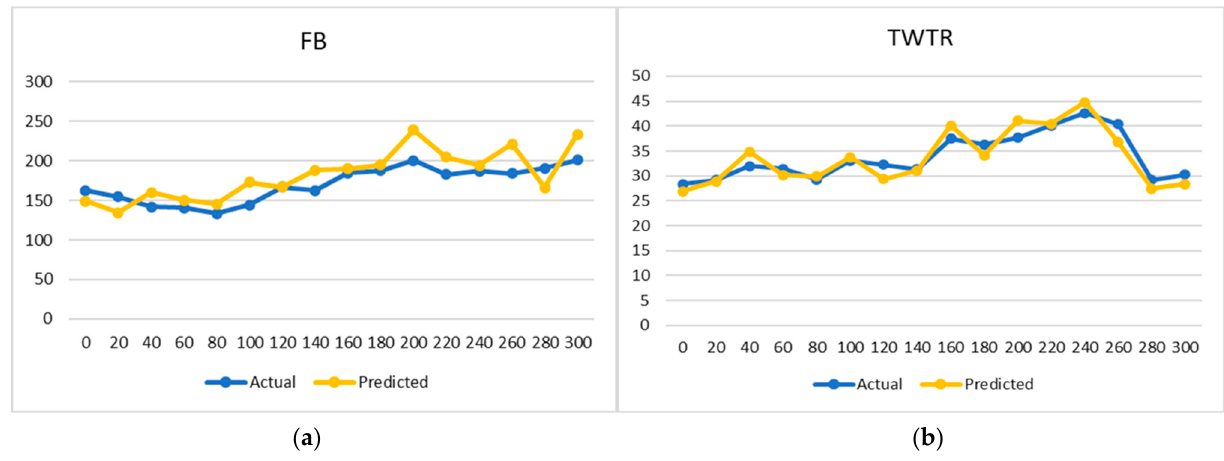
Figure 5. Price predicting graph for ( a ) FB and ( b ) TWTR.